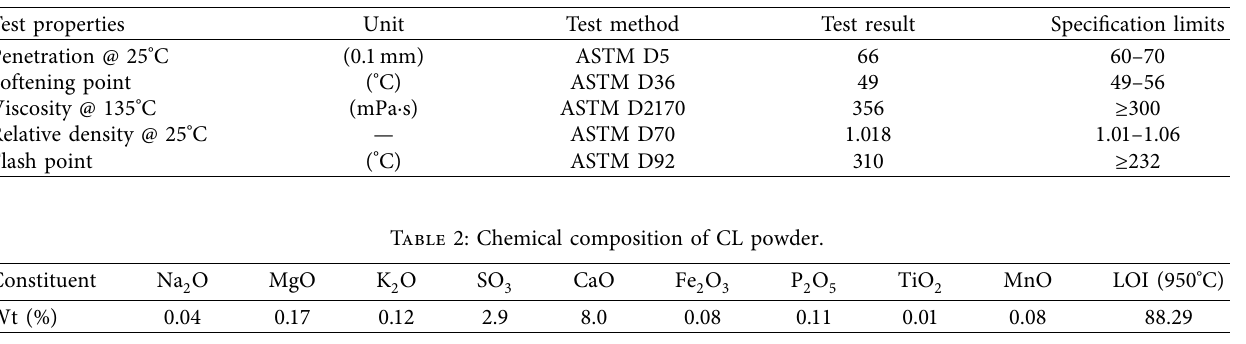
Table 1: Physical specifications of the neat asphalt binder.